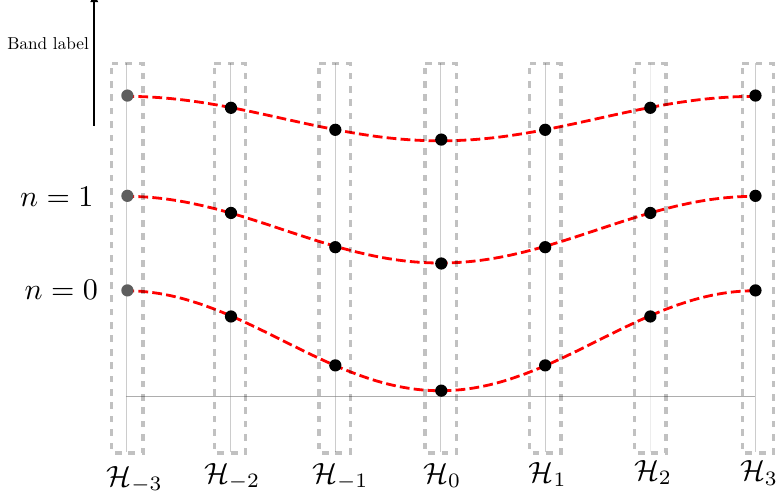
Figure 5 . The Hilbert space of the original T N model can be decomposed according to Z N quantum numbers associated with Bloch momenta p . θ